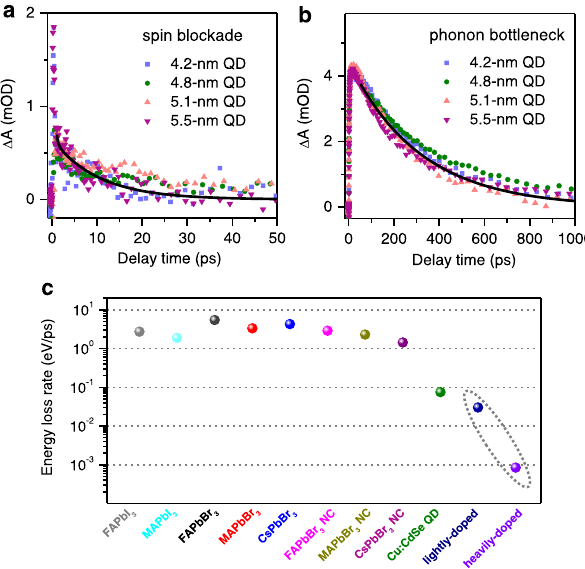
Fig. 6 Size dependence and comparison to other materials. Hot Electron relaxation in a lightly and b heavily n -doped QDs of varying sizes. c Hot carrier energy loss rates calculated for FAPbI 3 , MAPbI 3 , FAPbBr 3 , MAPbBr 3 , and CsPbBr 3 bulk fi lms, FAPbBr 3 , MAPbBr 3 , and CsPbBr 3 NCs, copper- doped CdSe QDs and lightly and heavily n -doped CdSe QDs. The last two samples (circled) are from this study, whereas the rest are adapted from the literature 37